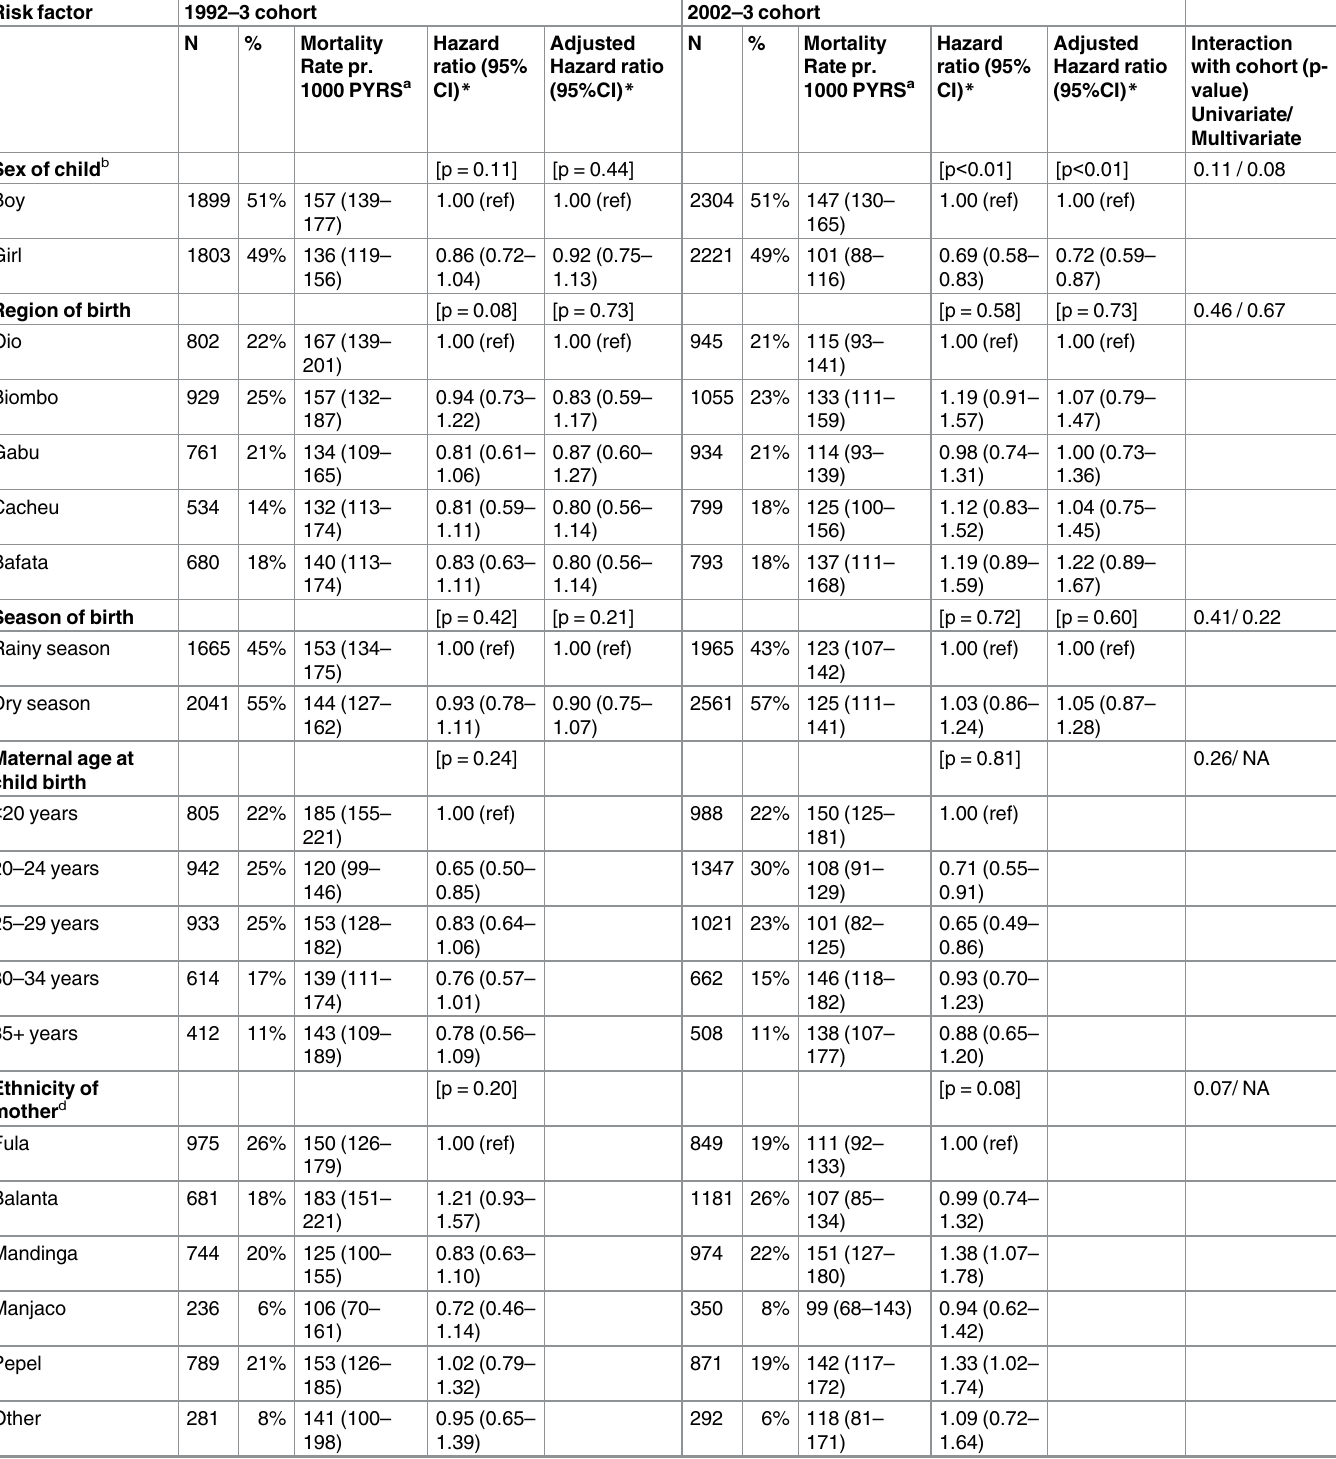
Table 2. Distribution (frequencies) and association of potential risk factors with infant mortality in the 1992–3and 2002–3birth cohorts (univariate and multivariate